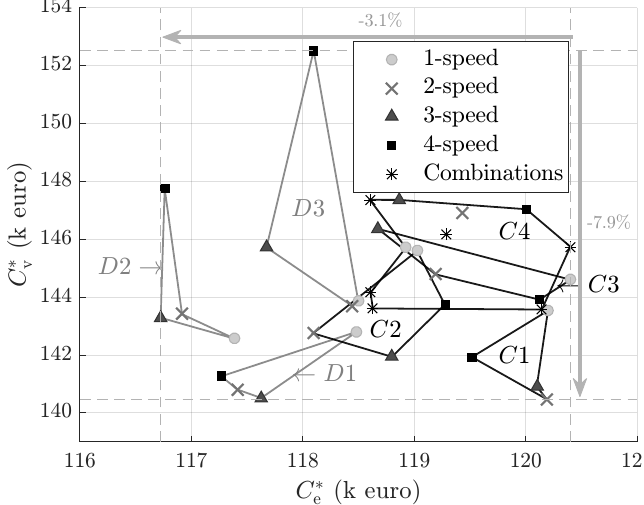
Figure 9. The vehicle cost C ∗ v plotted versus the electricity running cost C ∗ e for each optimized powertrain configuration. The data points belonging to the same topology are connected with lines, and the different markers indicate the gearbox type present. Gray colored lines are used for distributed topologies and black lines for central drive topologies. “Combinations” refers to the configurations of T C 4 equipped with two different types of gearboxes, for example a one-speed in combination with a two-speed